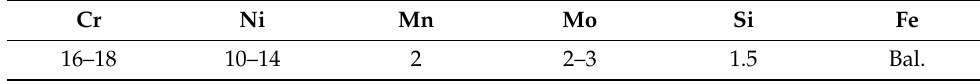
Table 1. Chemical composition of 316L SS (mass fraction, %).